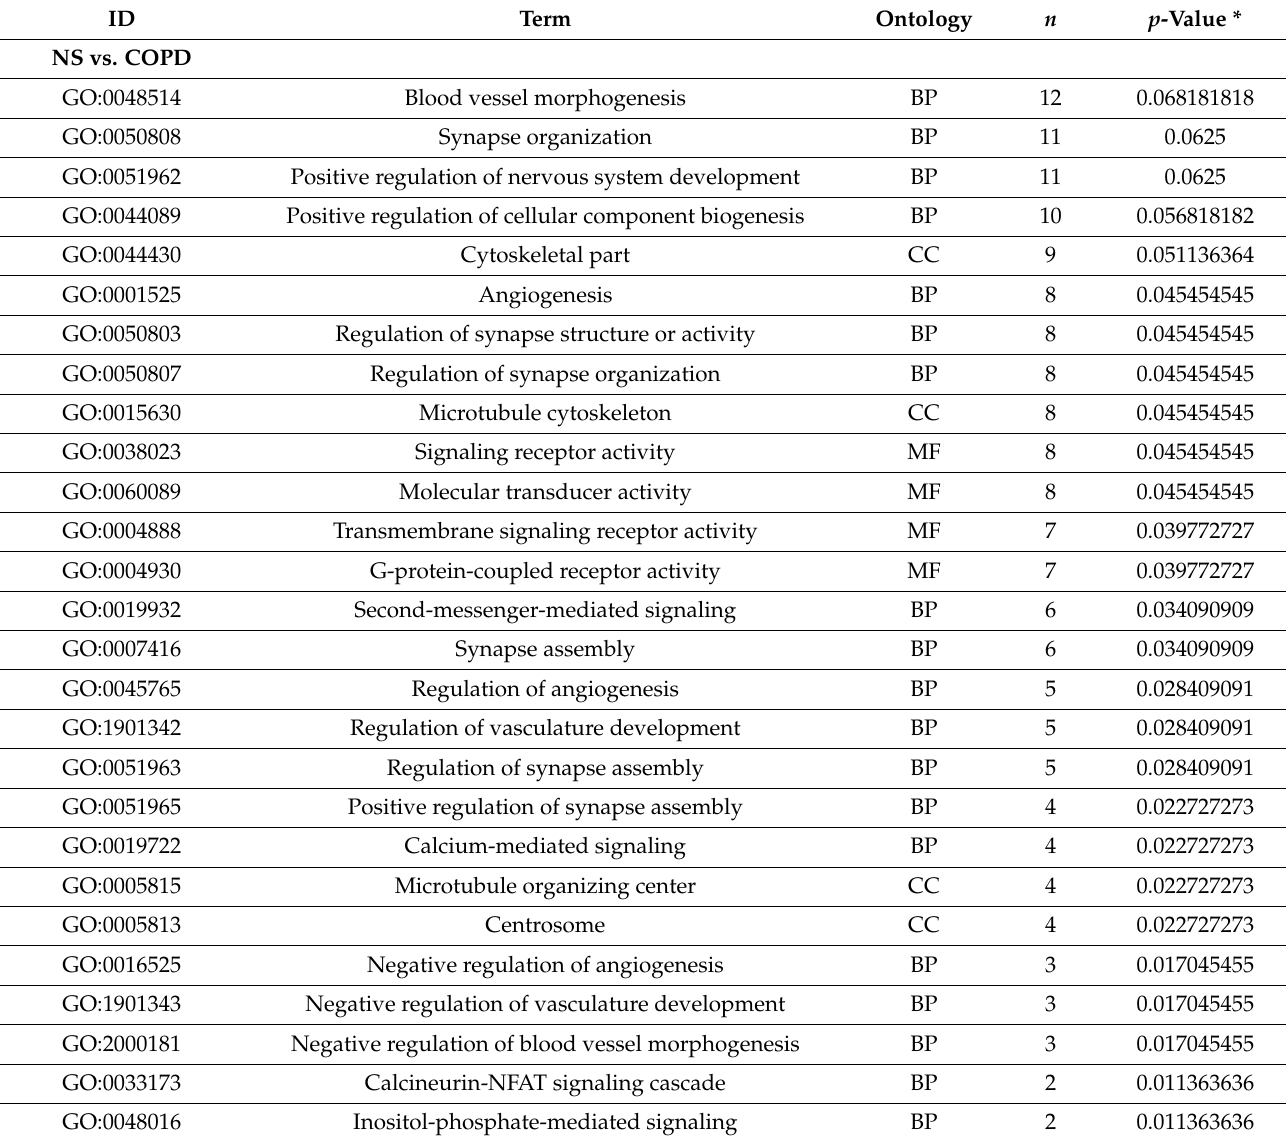
Table 2. GO enrichment analysis of differentially expressed miRNAs in lung-tissue-derived